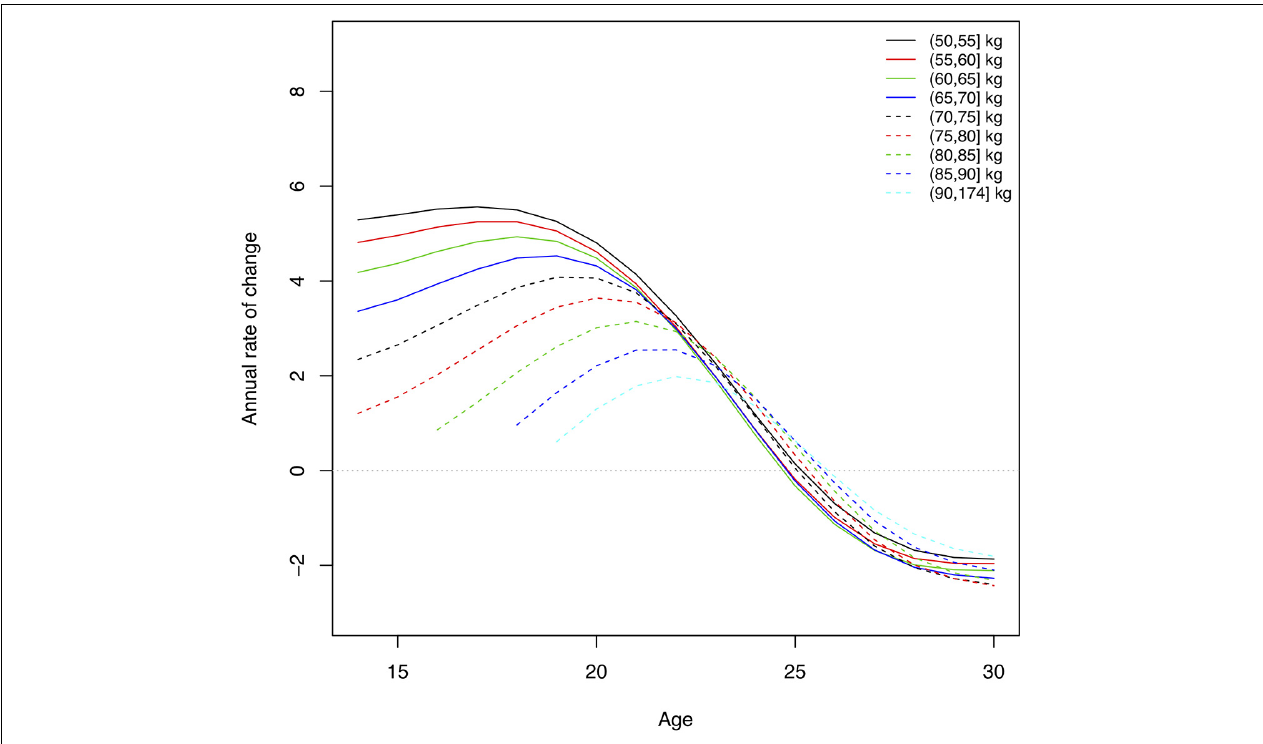
FIGURE 6 | Annual rate of change in performance levels, at 90th percentile, by age and body mass for women. Lines represent the rate of change in total weight lifted for athletes with different body mass. This corresponds to the derivative of the curves for performance levels, where zero indicates the age at which there was a maximum in the absolute performance level. TABLE 2 | Performance development, at the 50th and 90th percentiles, for different body weights: age at maximal annual rate of increase and age at peak performance. Women Men Age at max increase Age at peak performance Age at max increase Age at peak